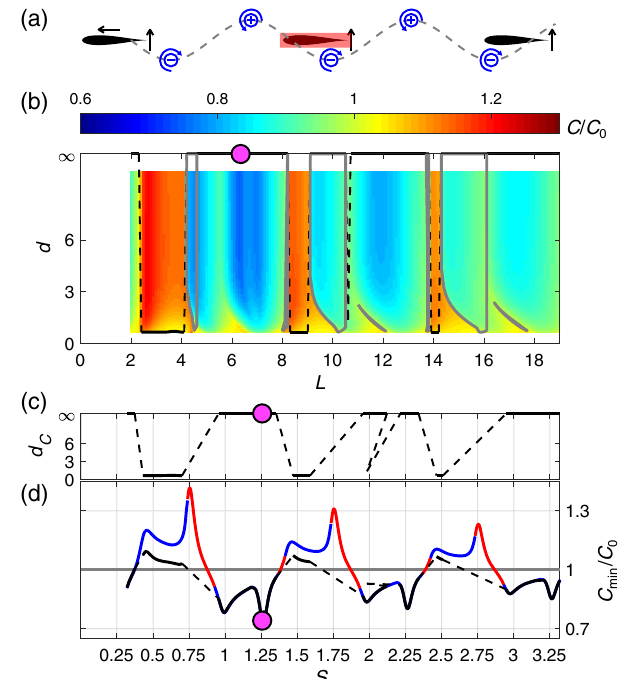
FIG. 6. Cost of transport in a rectangular lattice. (a) Schematic of the rectangular lattice of swimmers that minimizes the cost of transport C=C 0 . The minimal cost of transport C=C 0 ¼ 0 . 75 at L ¼ 6 . 3 and S ¼ 1 . 26 corresponds to that of an in-line formation [Fig. 3(c)], for which d → ∞ . This state is indicated by the pink dot in (b) – (d). (b) The color map shows the normalized cost of transport C=C 0 as a function of L and d , based on numerical simulations of the rectangular lattice formation. The black curve d L Þ indicates the optimal lateral spacing as a function of the C ð L Þ plotted streamwise spacing L . (c) Optimal lateral spacing d C ð as a function of the schooling number S . (d) The associated cost =C 0 (black), superimposed on top of the results of transport C min for an in-line formation from Fig.